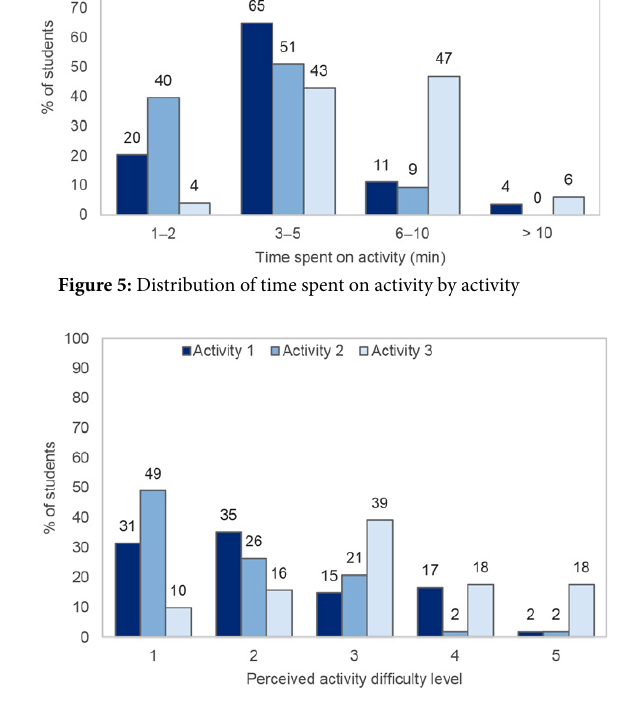
Figure 4: Distribution of activity completion levels by activity (5 = fully completed)